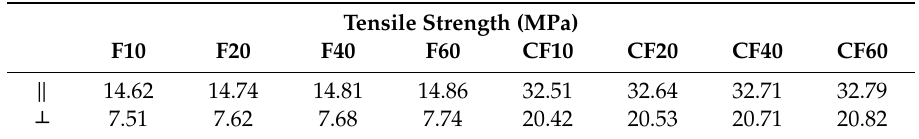
as illustrated in Figure 6b. Since PMMA has good transmission of light, the light beam can be manipulated outside freely to control the membrane actuator. As illustrated in Figure 6c, when irradiating the film with UV light from the outside of the PMMA chamber the valve will be opened,